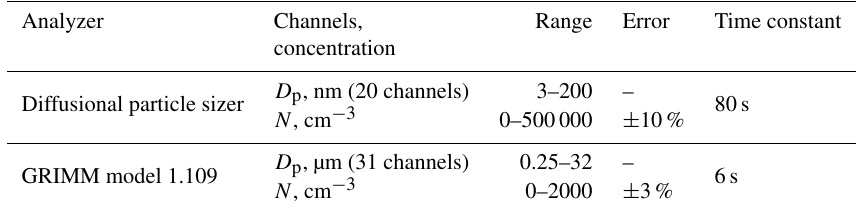
Table 2. Technical characteristics of the aerosol system (disperse